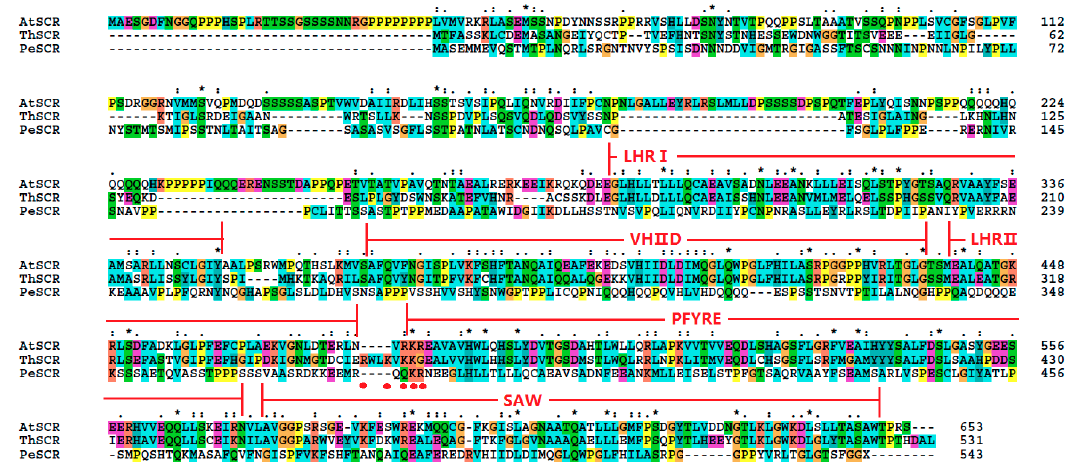
Figure 3. Alignment of the amino acid sequences of ThSCR with those of SCARECROW (SCR) of both Arabidopsis and Populus .